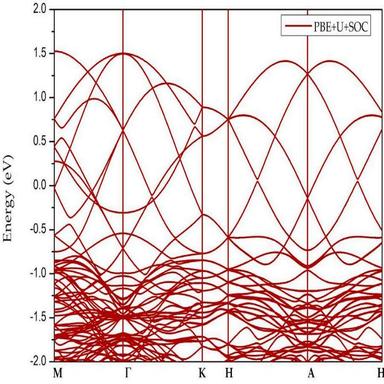
Calculated band structure of rhombohedral R3c-type HoNiO3 with SOC.